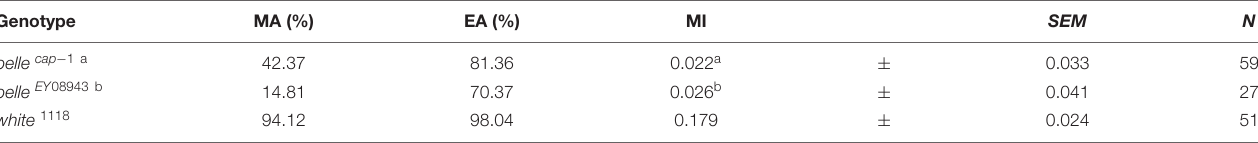
TABLE 3 | Locomotor activity of belle mutants in entrainment conditions (LD).